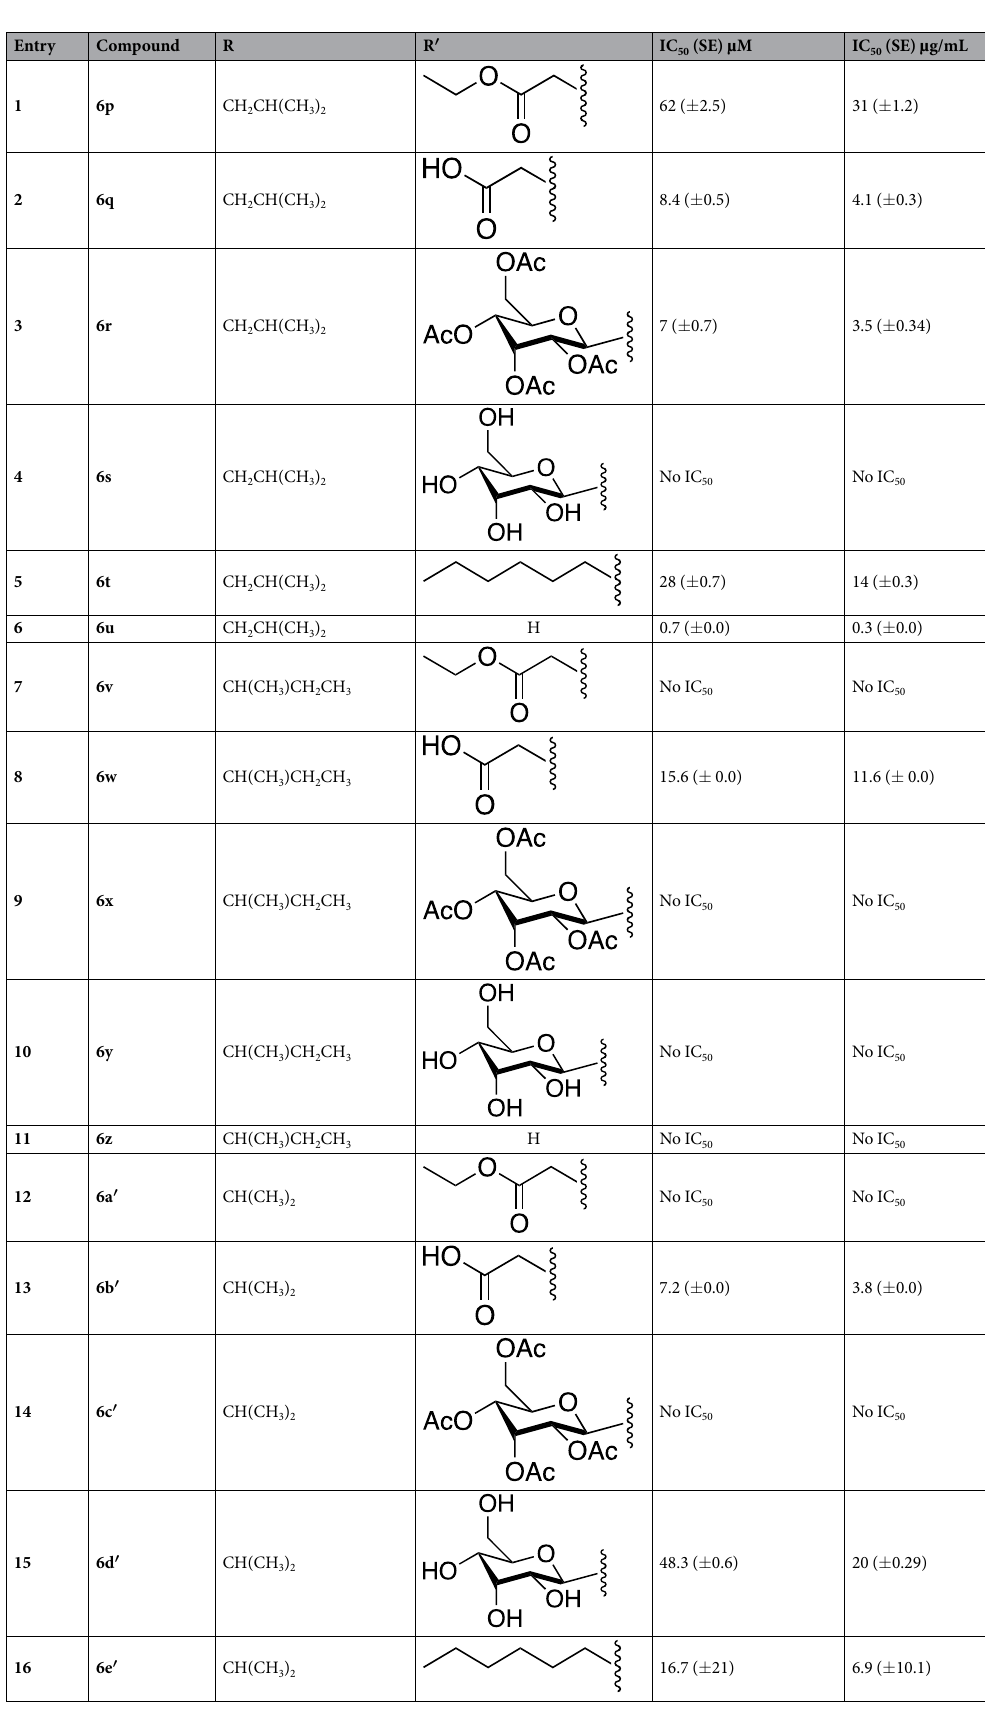
Table 2. SAR of R ′ Substituent Antimalarial Activity: Aliphatic and Glycoside